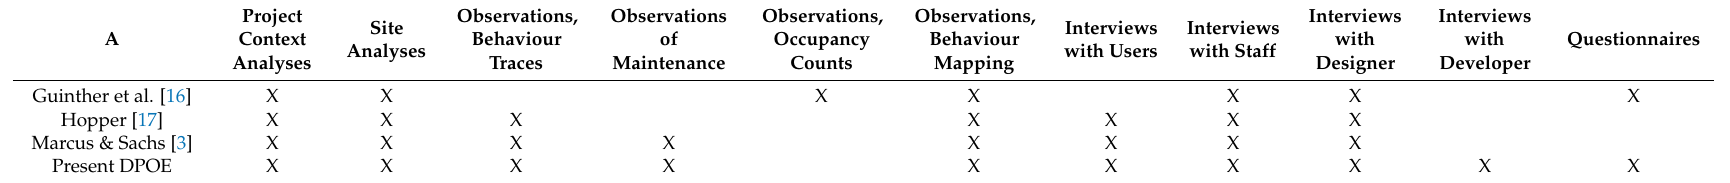
Table 1. The various methodological frameworks applied in diagnostic POEs based on relevant